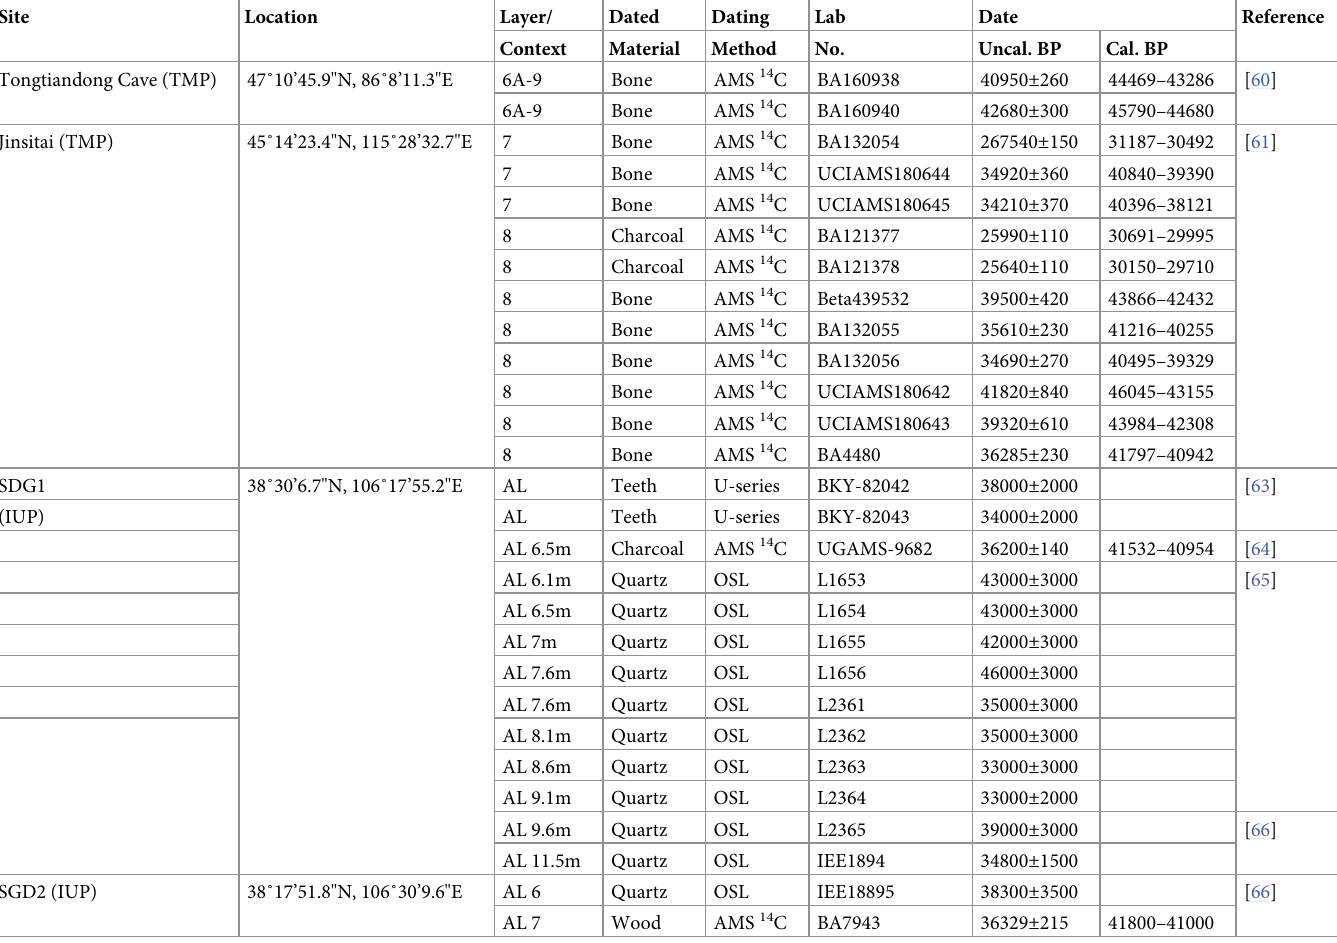
Table 1. Chronological information about the MP and IUP techno-complex sites in northern China. The radiocarbon data was calibrated by using OxCal 4.4 and IntCal20 calibration curve. Site Location